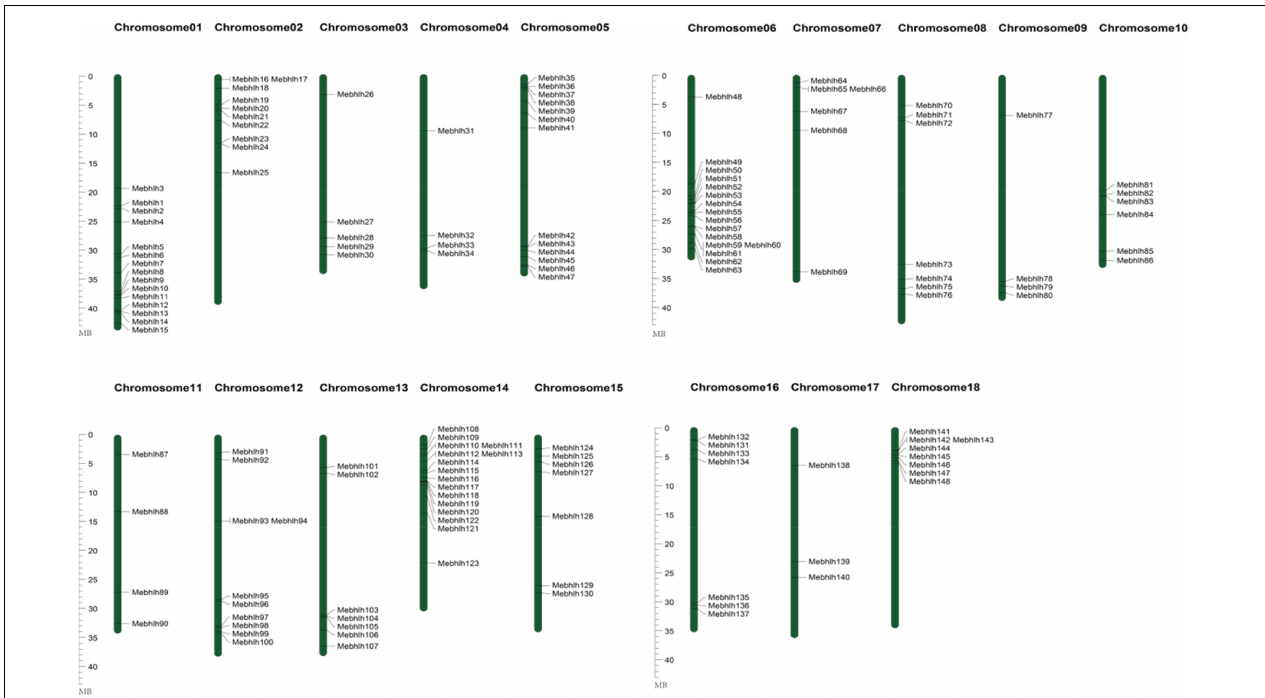
FIGURE 2 | Chromosomal locations of the MebHLH genes. The color gradient provided a scale from 0 to 100% for assessing the magnitude of the parameters. Blue bars denote the Manihot esculenta chromosome. Scale bar on the left indicates the chromosome lengths (Mb).